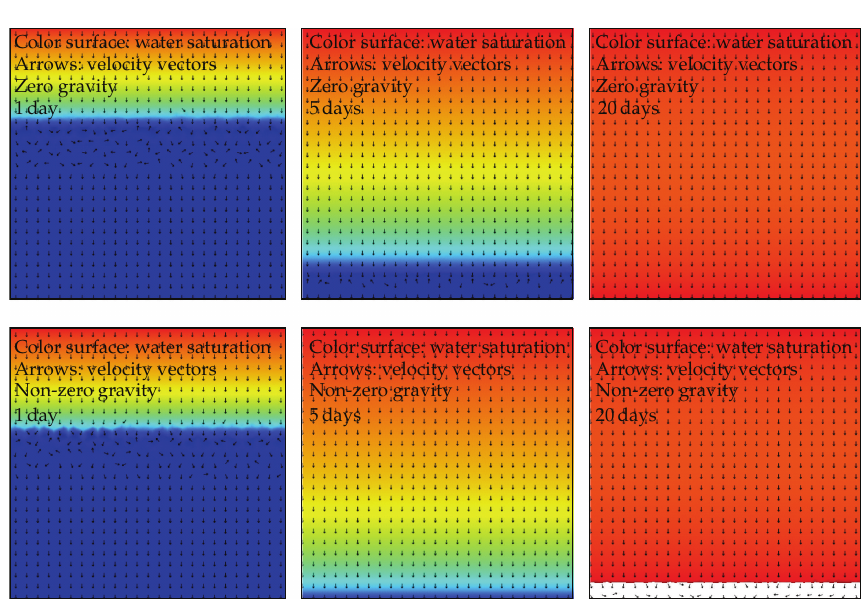
Figure 8: Distributions of water saturation and velocity vectors of zero, nonzero gravity for the top-inlet case.